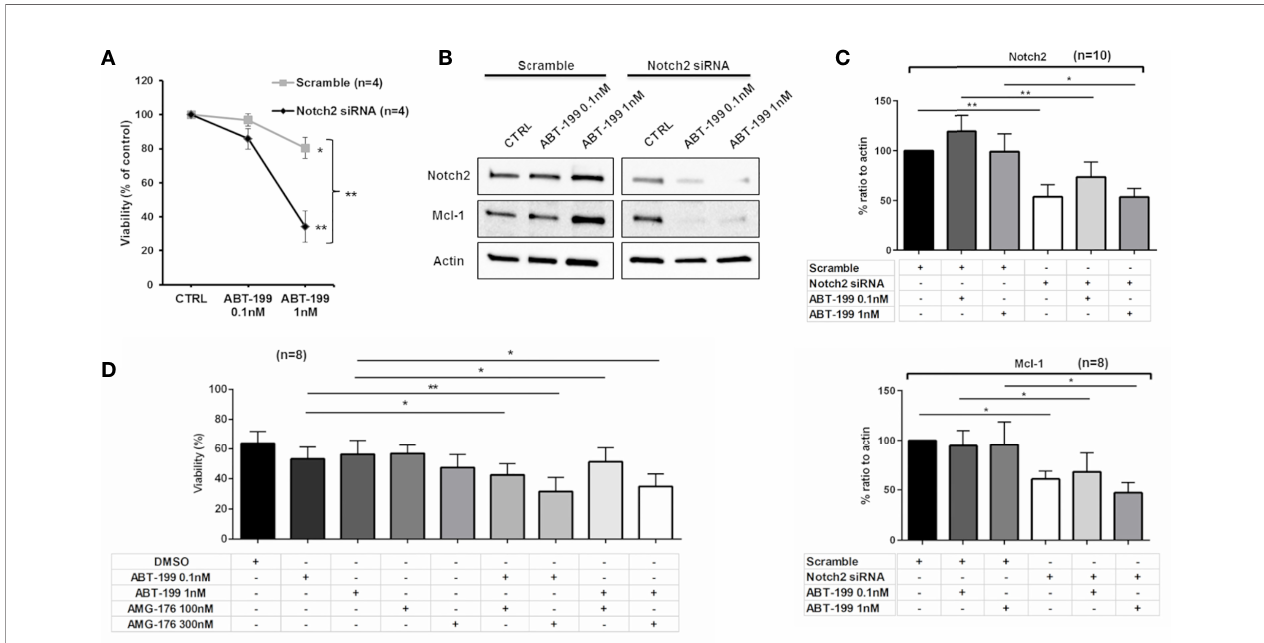
FIGURE 5 | Combination of venetoclax and inhibition of Mcl-1 induces apoptosis in trisomy 12 chronic lymphocytic leukemia (CLL) cells. (A) Diagram shows the percentage of survival in CLL cells transfected with scramble or Notch2 siRNA in the presence of treatment with venetoclax for 24 h (*p < 0.05, **p < 0.01). (B) Immunoblots show the level of Notch2, Mcl-1 in one representative CLL patient harboring trisomy 12 during treatment with venetoclax after transfection with either scramble control or Notch2 siRNA (*p < 0.05, **p < 0.01). (C) Bar diagrams depict the densitometric quanti fi cation of Notch2 and Mcl-1 in CLL cells harboring trisomy 12 transfected with scramble or Notch2 siRNA either in combination or not with venetoclax (*p < 0.05, **p < 0.01). (D) Trisomy 12 CLL cells were either treated with dimethyl sulfoxide (DMSO) or treated with 0.1 or 1 nM venetoclax, 100 and 300 nM AMG-176, or a combination of both for 48 h. Bar diagrams show the viability (%) in each condition measured by fl ow cytometry (*p < 0.05, **p <